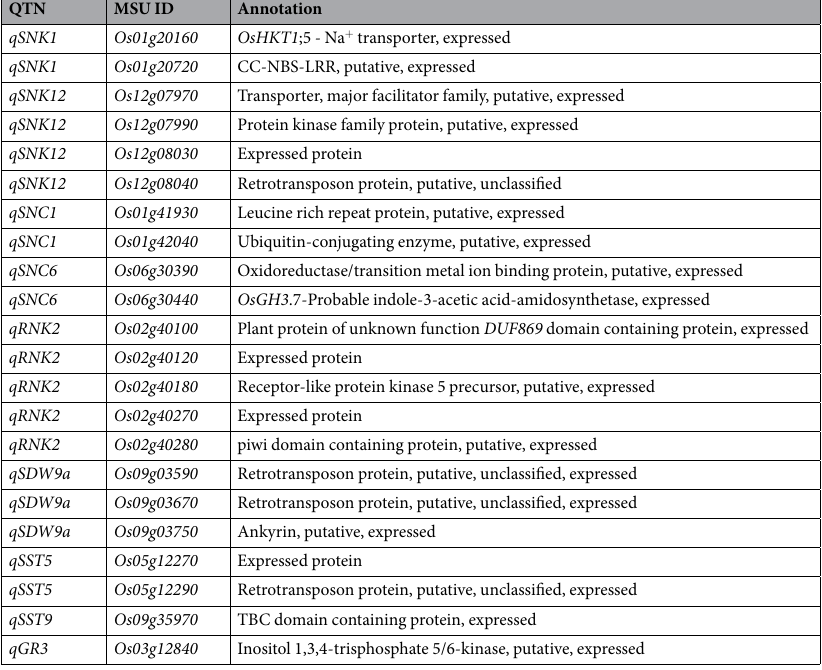
Table 5. List of 22 candidate genes for seven important QTN identified at seedling stage under